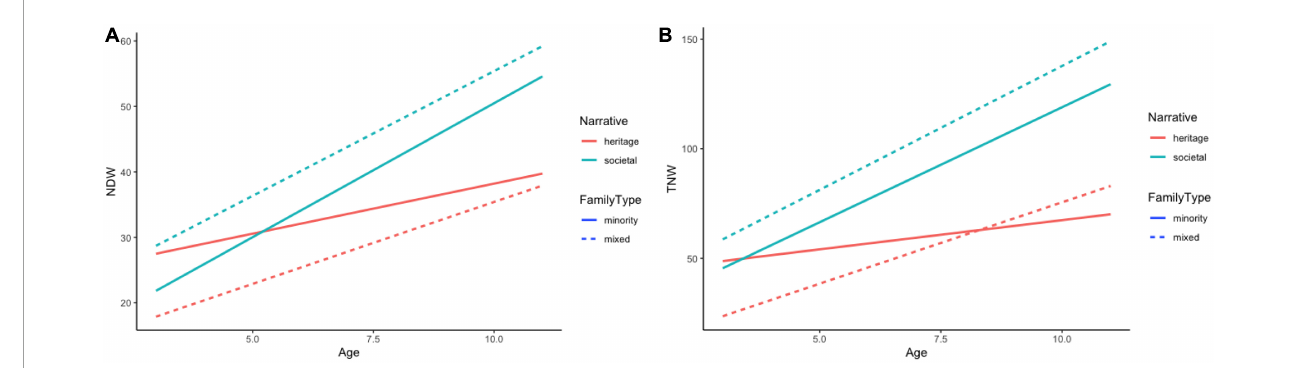
FIGURE4 Development of number of different words (NDW) (A) and total number of words (TNW) (B) in the societal and heritage language as a function of age and family type.